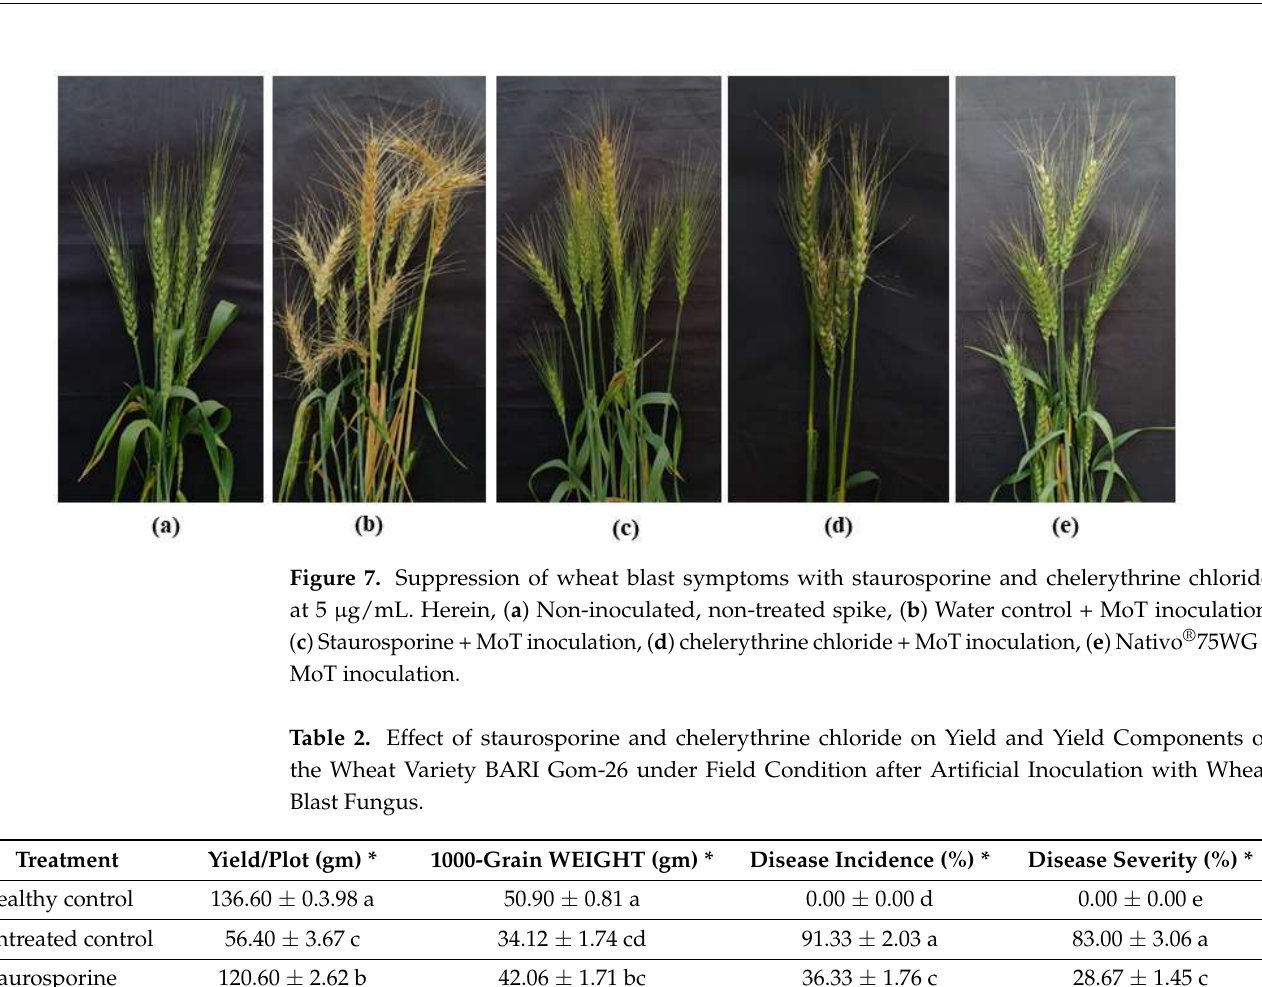
Table 2 . Effect of staurosporine and chelerythrine chloride on Yield and Yield Components of the Wheat Variety BARI Gom-26 under Field Condition after Artificial Inoculation with Wheat Blast Fungus .